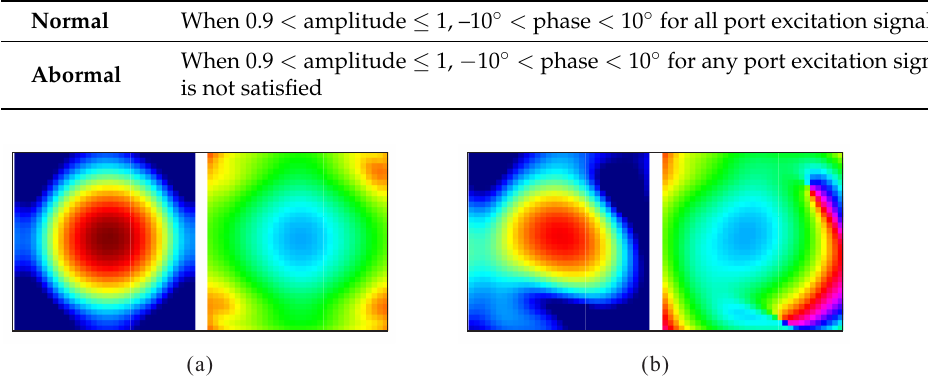
Figure 3. Examples of near-field data in case of ( a ) normal and ( b ) abnormal